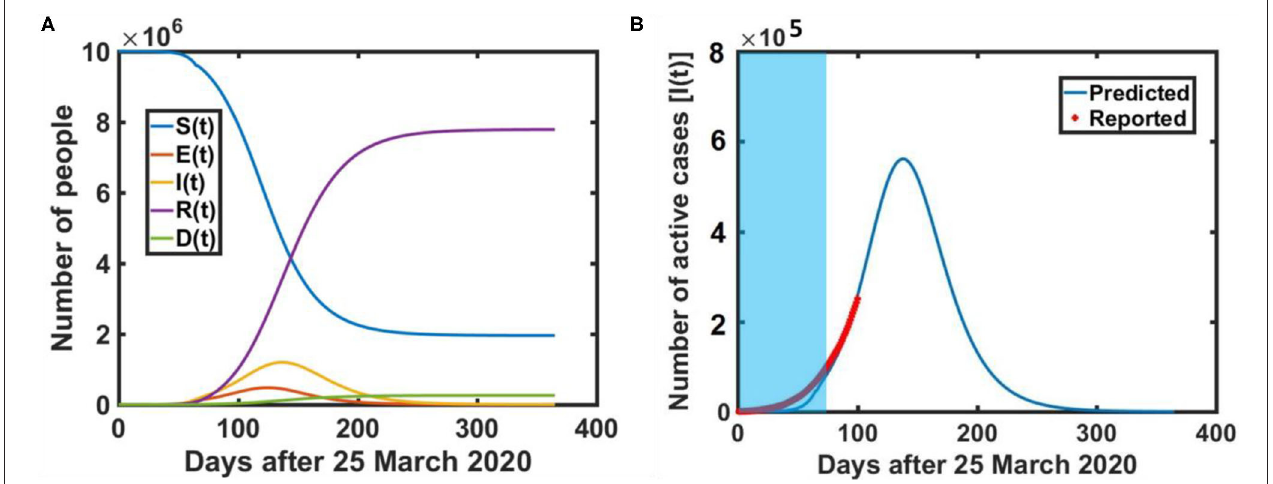
FIGURE 6 | Mathematical model prediction of COVID-19 dissemination in India, (A) Five compartment trajectory over time (B) COVID-19 epidemic peak i.e., maximum active cases prediction in India. [Blue shaded region represents the actual lockdown period]. The incubation period and recovery rate are taken as 5.2 days